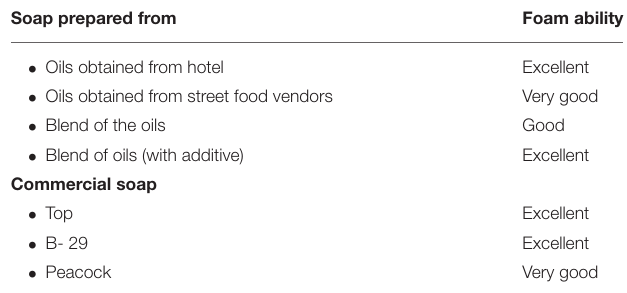
TABLE 7 | The lather stability values of prepared and commercial soap